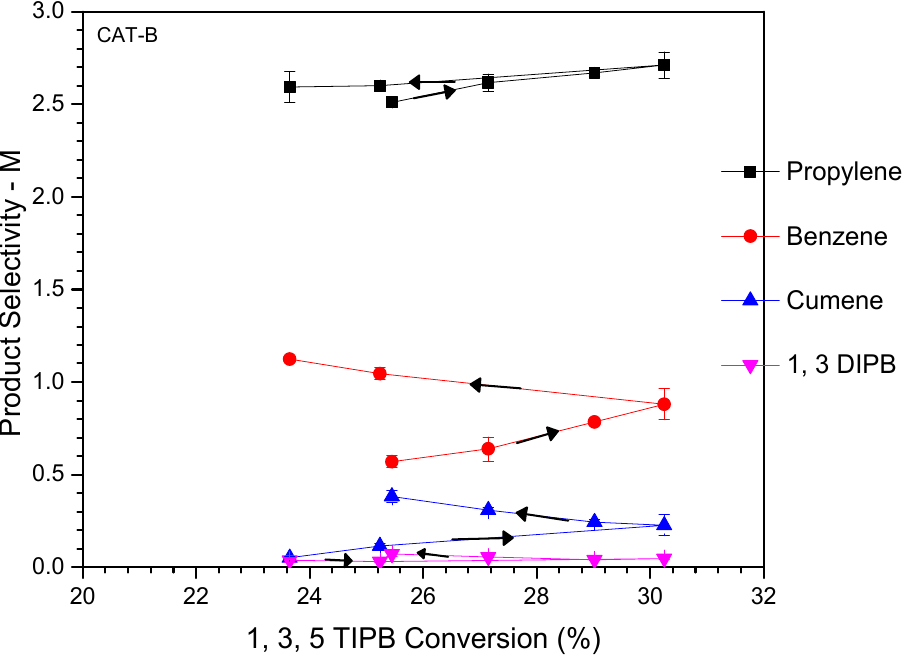
Figure 9. E ff ect of C / O on the product selectivity using TIPB on selected catalyst CAT-B. The temperature Figure 9. Effect of C/O on the product selectivity using TIPB on selected catalyst Cat-B . The and contact time were kept constant at 550 ◦ C and 7 s, respectively. Notes: a) direction of the “arrows” temperature and contact time were kept constant at 550 °C and 7 s, respectively. Notes: a) direction represent increasing C / O ratios; and b) reported data and standard deviations (vertical bars) represent of the “arrows” represent increasing C/O ratios; and b) reported data and standard deviations average values for 4–7 repeat (vertical bars) represent average values for 4–7 repeat runs.